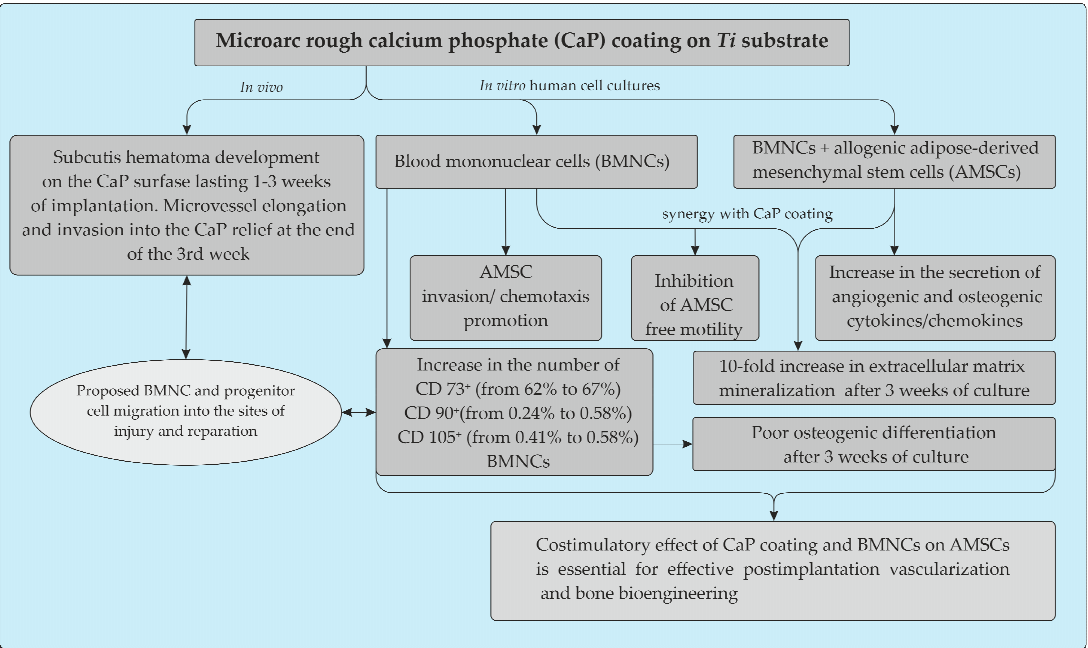
Figure 9. Schematic representation summarizing the in vitro and in vivo e ff ects of the microarc CaP coating on a titanium